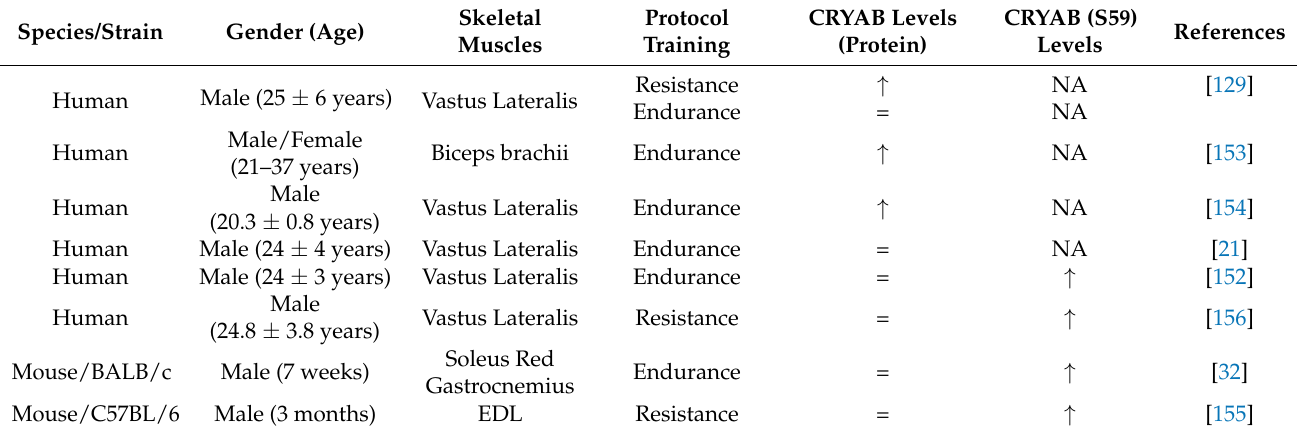
Table 3. CRYAB expression levels in different skeletal muscles after physical